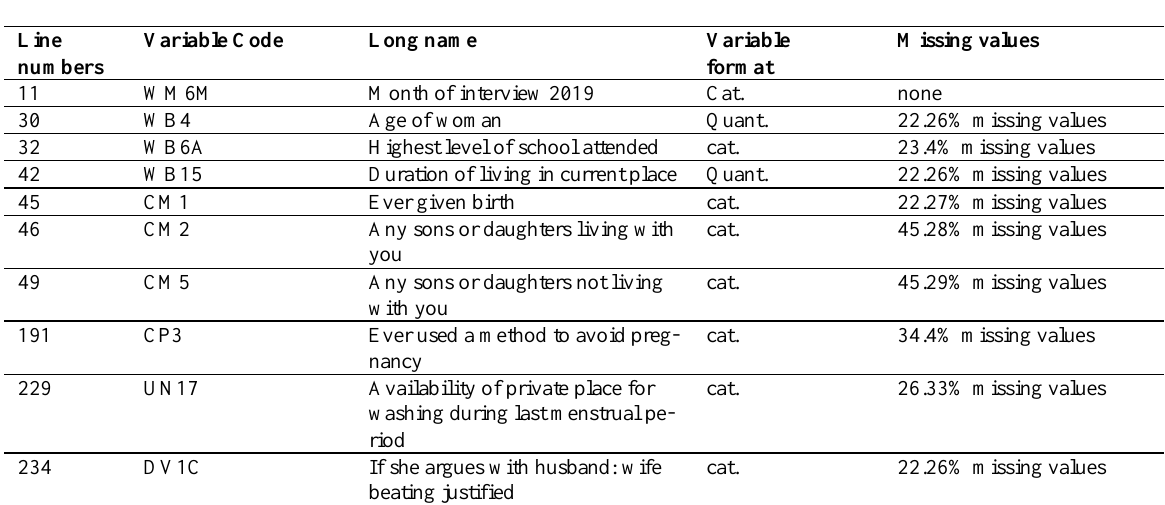
Table 1. Selection of the 26 most relevant variables from the MICS database (UNICEF 2019) having a sufficiently high response rate, at least bi-categorical answers, and missing values below 50% (full list in